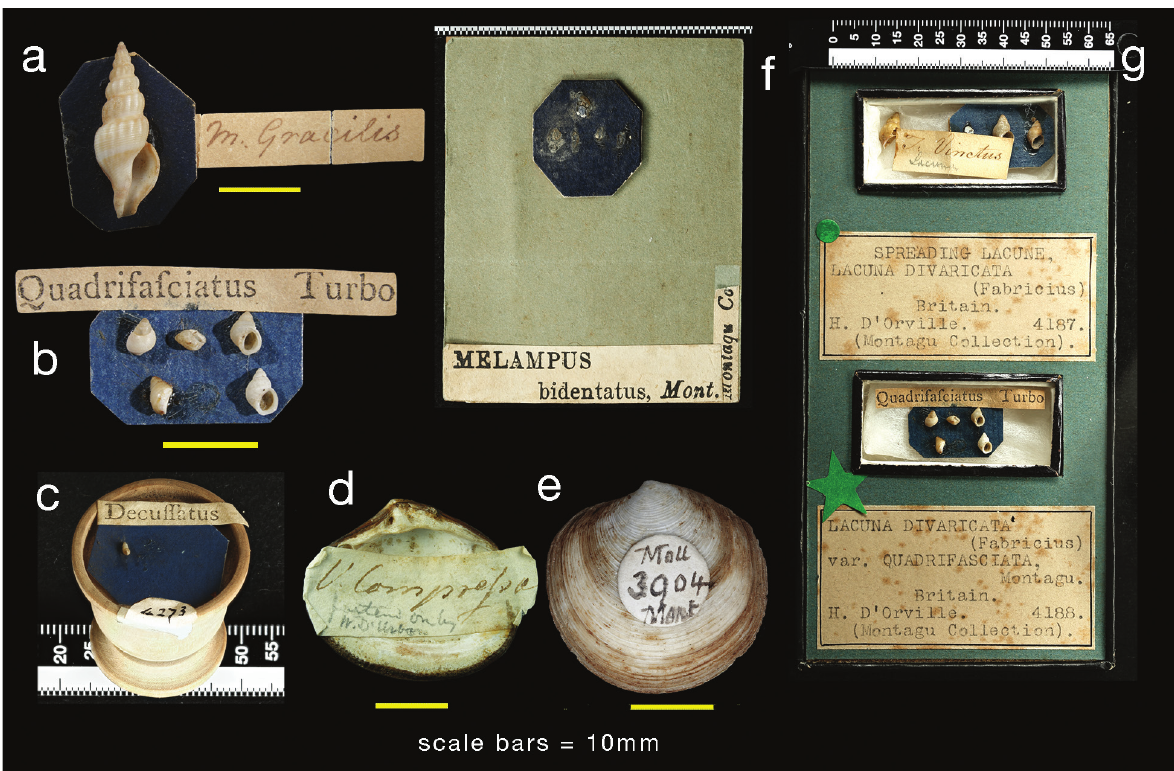
Figure I3. Labels and mounts associated with the Montagu collection in RAMM, Exeter. a Montagu hexagonal blue card with spec- imen and original hand written label b Montagu hexagonal blue card with specimens and original printed label c Montagu hexagonal blue card with specimen attached to a wooden urn-shaped plinth. d Original label attached to inside of shell e RAMM registration disc attached to shell f Early block with green paper cover with Montagu hexagonal card attached g. “Rowley box” mount with glass topped boxes containing Montagu hexagonal